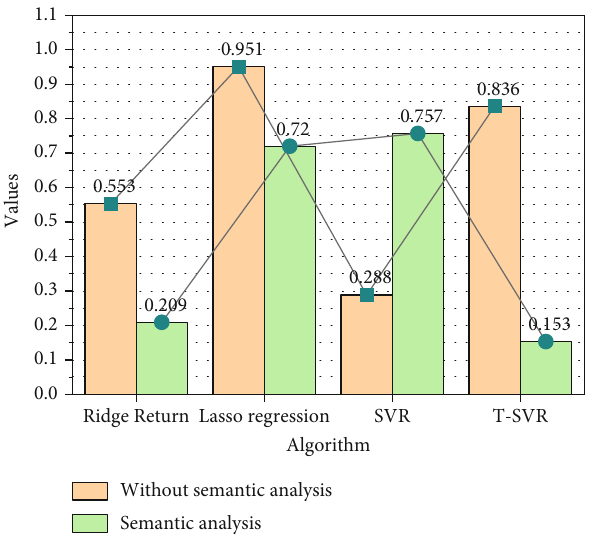
Figure 5: Comparison of results between recognition algorithms.